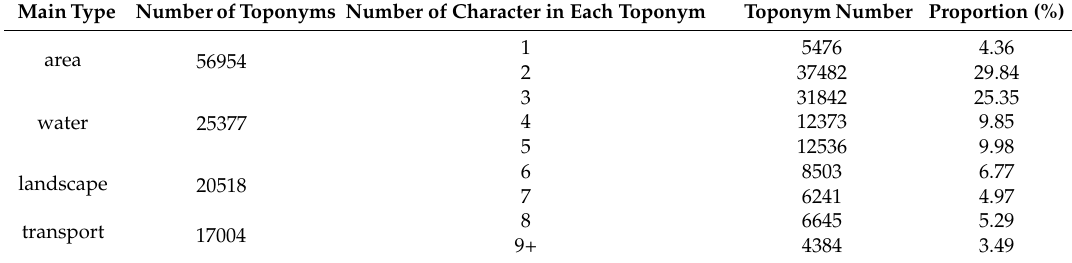
Table 1. Distributions of the ECCG corpus.